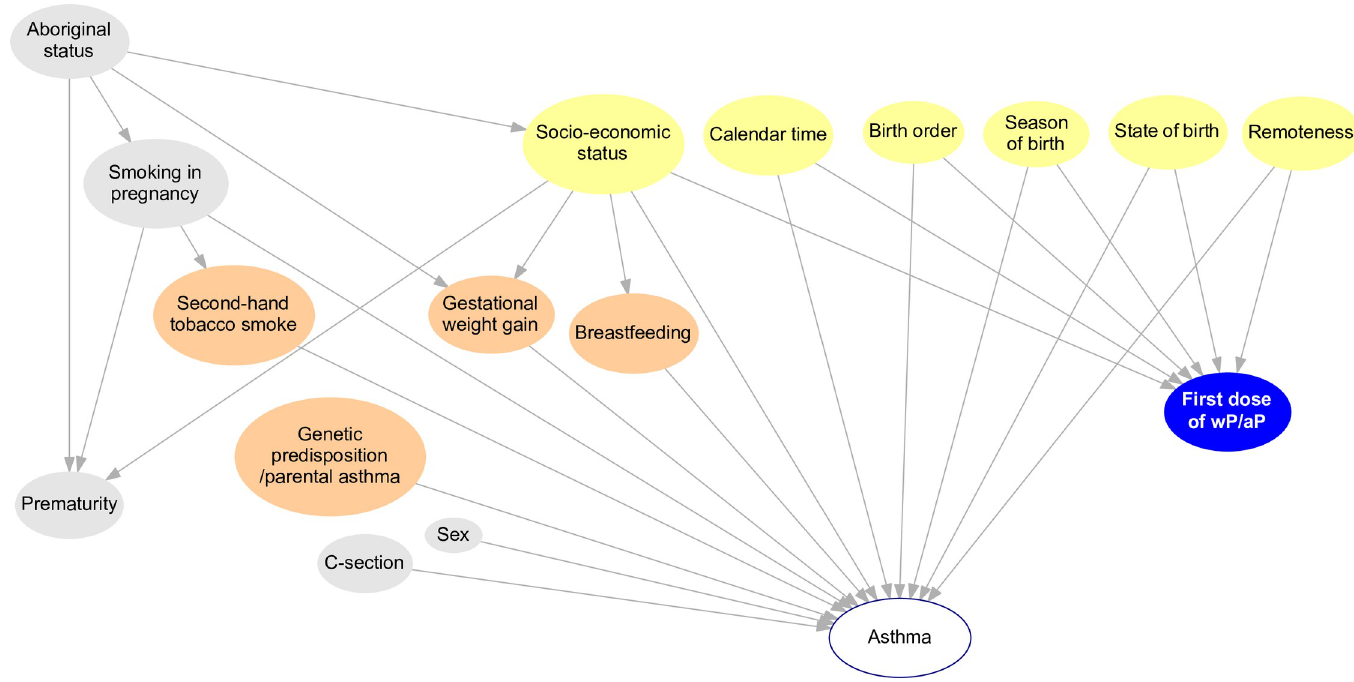
Fig 3. Direct acyclic graph before adjustment by confounders and baseline covariates. The blue node represents the exposure (wP or aP); orange and grey nodes: Perinatal, environmental and biological factors at birth/before the exposure that may influence the outcome of interest, but not the receipt of the study vaccines; brown nodes: Confounders of the association between the exposure and atopic asthma; yellow nodes: Adjusted variables; white node: Outcome of interest. Because the association between low birthweight and asthma is mainly driven by gestational age at delivery, birthweight is not depicted in this diagram [40]. C-section: Birth by caesarean. Data are available for all the nodes except for those in